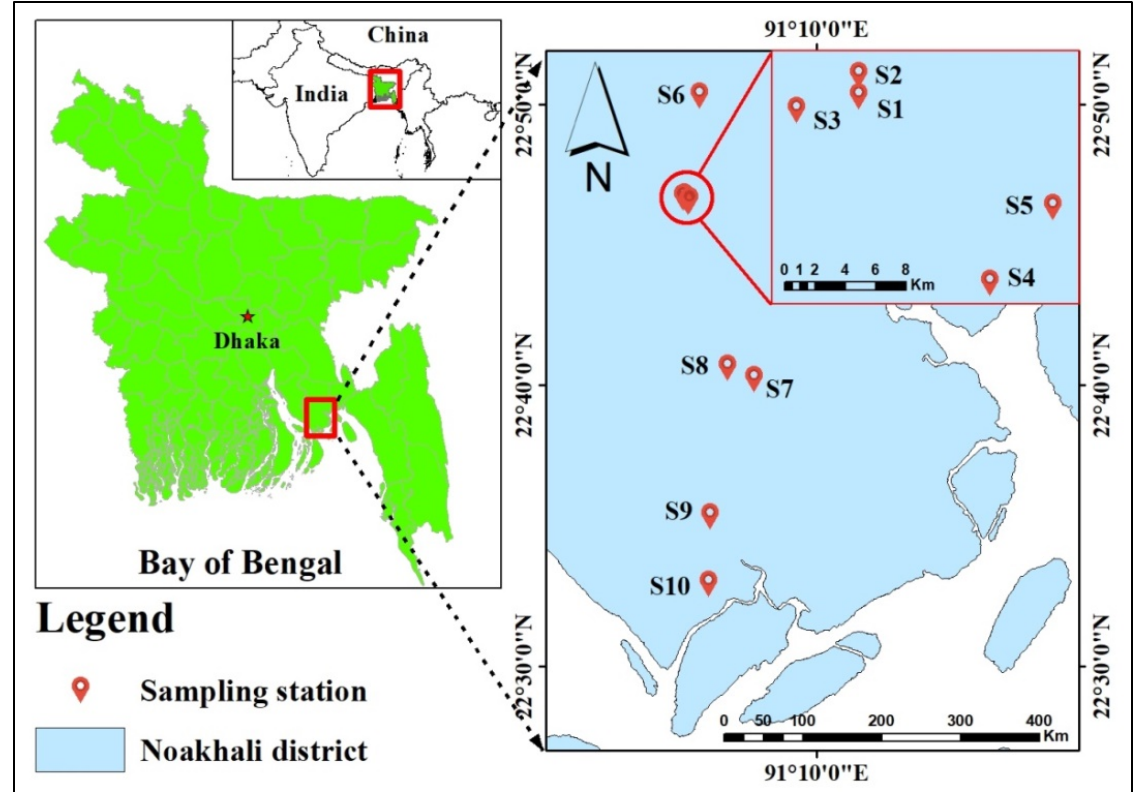
Figure 1. Map showing the location of the study area.